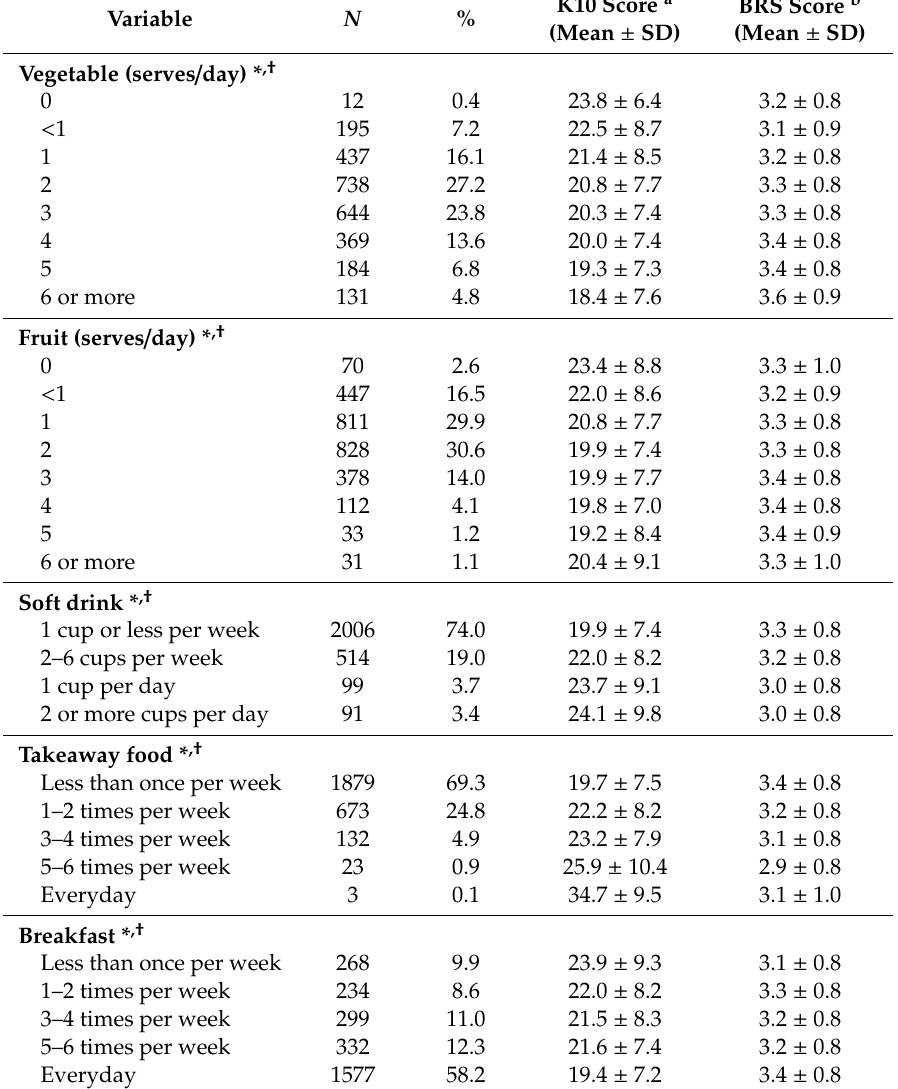
K10 Score a BRS Score b (Mean ± SD) (Mean ± SD)